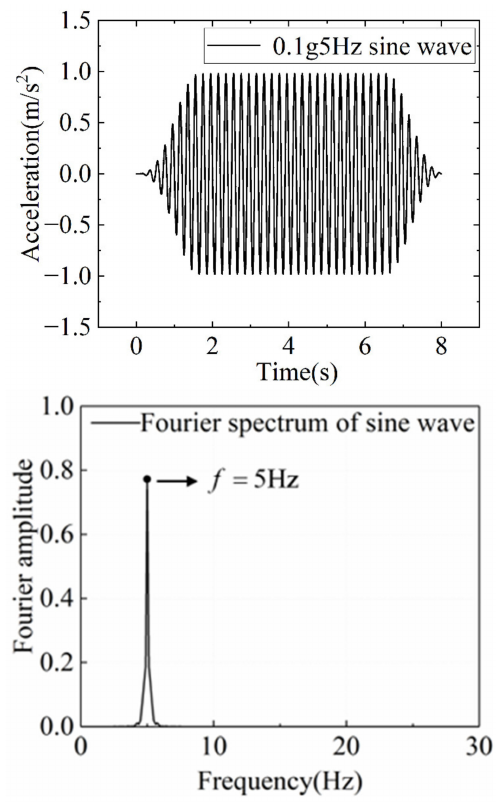
Figure 6. 5 Hz sine wave waveform and Fourier spectrum.